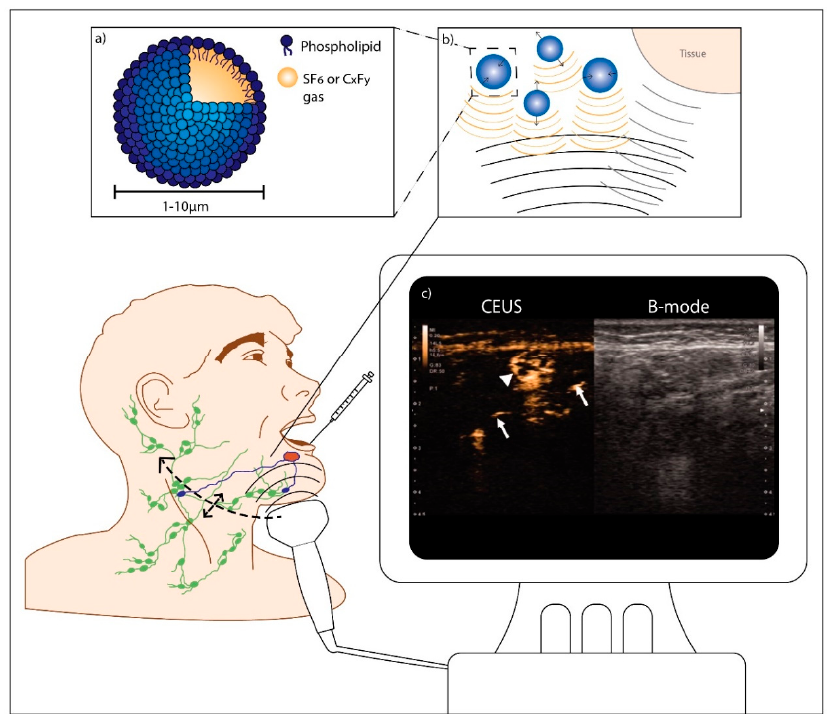
Figure 7. Contrast-enhanced lymphosonography in oral cancer. After microbubble injection at one or multiple peritumoral locations, contrast-enhancement of the injection site is visualized in ultrasound contrast mode. Using real-time imaging, the transportation of the microbubbles through lymphatic vessels may be followed until they accumulate in the sentinel lymph nodes. Subsequently, the neck is scanned for additional contrast-enhanced lymph nodes. Contrast-enhanced lymph nodes can be either marked for surgical resection or directly subjected to biopsy or aspiration cytology. Peritumoral injections can be repeated if necessary. ( a ) Schematic representation of a microbubble; ( b ) Principle of contrast-enhanced ultrasound (CEUS): oscillating microbubbles produce strong nonlinear scattering which can be distinguished from scattering by the surrounding tissue; ( c ) Contrast-enhanced ultrasonography with Sonazoid. On the left half is a contrast-enhanced image, and on the right is the B-mode image. Contrast-enhancement of sentinel lymph nodes (SLNs) (arrowheads) was observed concomitant with lymphatic ducts (arrows) draining the nodes. (Adapted with permission from [35],